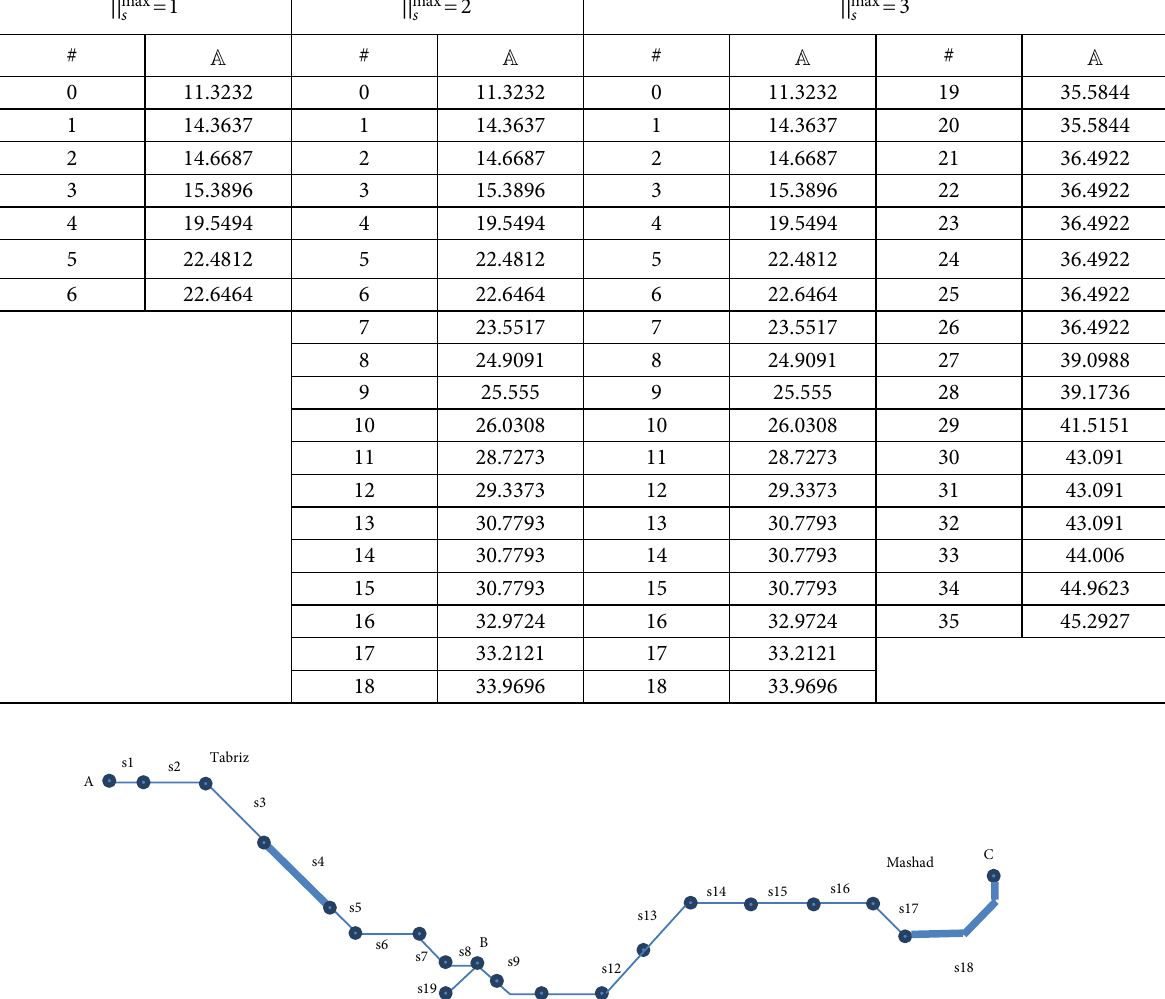
Table 11. Expansion results when flow is equal across all the corridors (i.e. PF = 1/9)